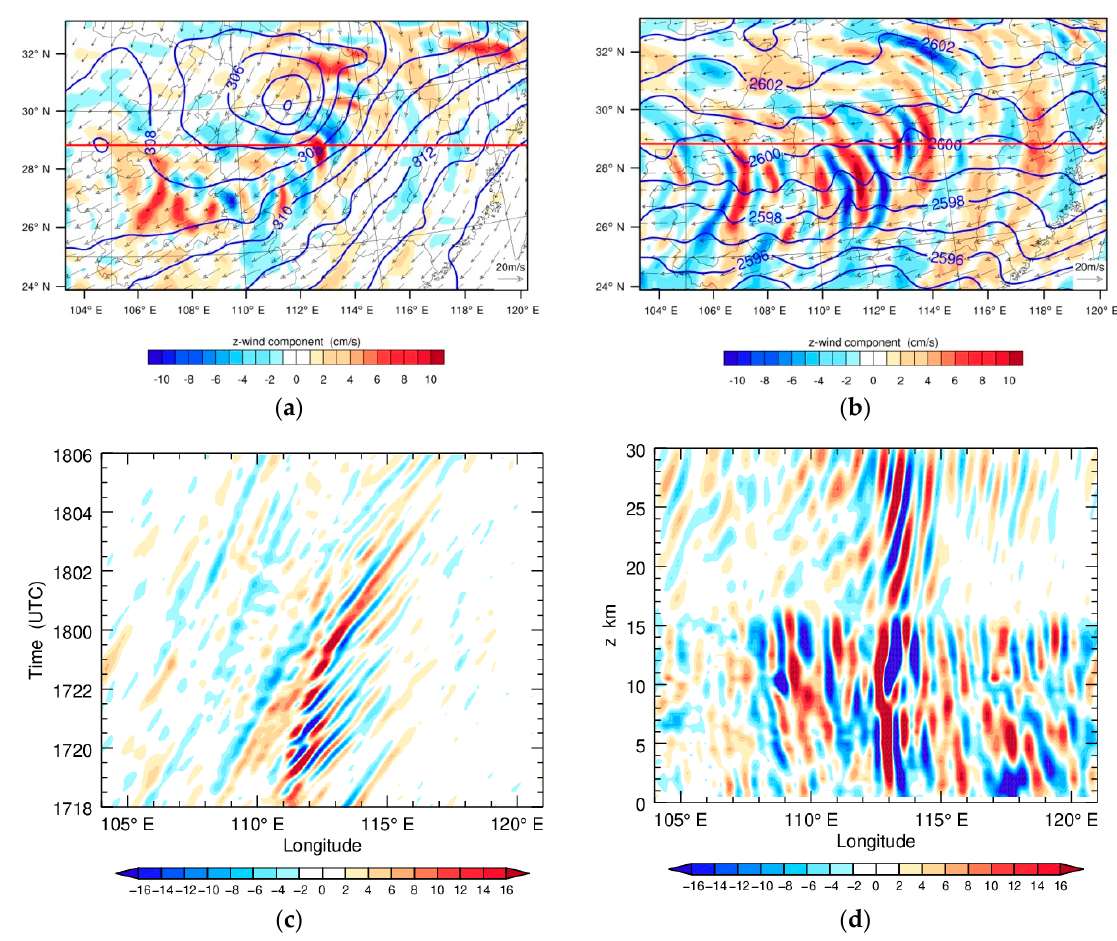
Figure 4. Horizontal distributions of vertical velocity (shading; cm s − 1 ) and horizontal wind (arrows; m s − 1 ) at 0000 UTC 18 June for ( a ) z = 18 km and geopotential heights at 700 hPa (blue lines; dagpm), and ( b ) z = 26 km and geopotential heights at 22 hPa (blue lines; dagpm). The red lines in ( a ) and ( b ) indicate the same truncated lines of cross-section. ( c ) Time–longitude distribution of the 50–200 km bandpass-filtered vertical velocity (units: cm s − 1 ) at z = 18 km along the red line in ( a ) from 1800 UTC 17 June to 0600 UTC 18 June, and ( d ) the vertical cross-section of vertical velocity (shading; cm s − 1 ) along the red line in ( a ).